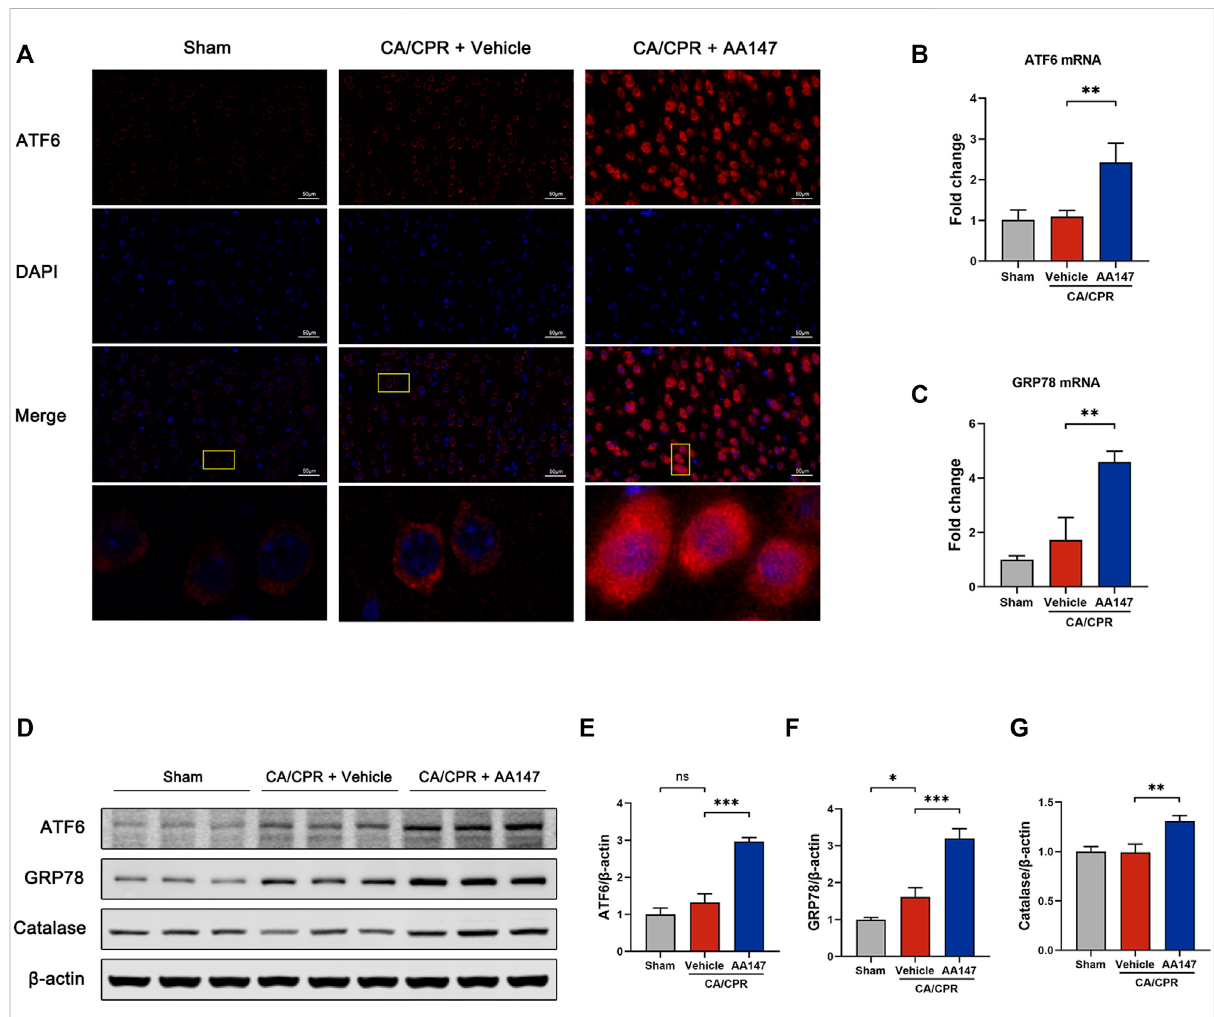
FIGURE 5 ATF6 signaling pathway was activated by AA147 in neurons after cardiac arrest and cardiopulmonary resuscitation (CA/CPR). The brain tissue samples of mice in each group were collected at 1 day after CA/CPR to determine whether the ATF6 signaling is activated by AA147. (A) Representative imagesofimmuno fl uorescentstaining ofATF6(red)showed that AA147promotednucleartranslocationofATF6. Scalebar=50 μ m. (B) The mRNA expression of ATF6 and (C) its downstream gene GRP78 were determined by qPCR. (D) Western blot analysis of (E) ATF6, (F) GRP78,and (G) catalaseproteinlevelsinthehippocampusofeachgroup.Dataaredisplayedasmean±SD(n=3).* p < 0.05.** p < 0.01.*** p <